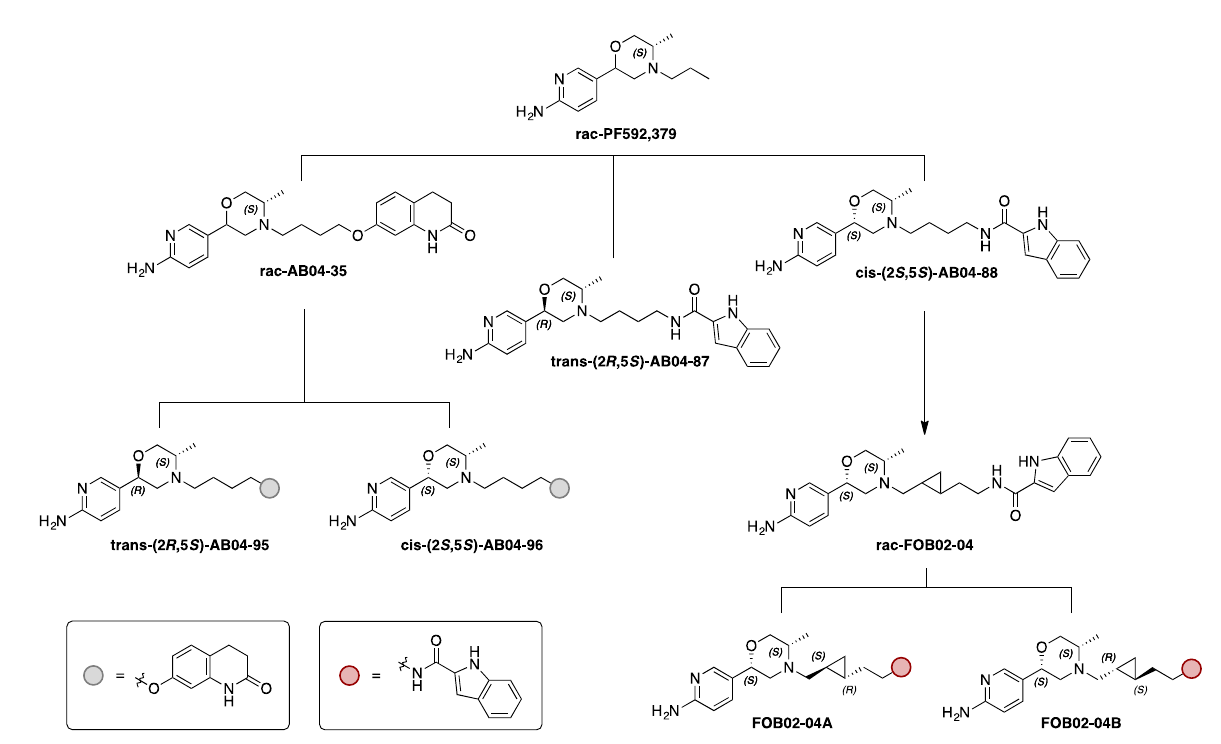
Figure 1. Drug design for D 3 R agonists. For the bitopic ligand design, the primary pharmacophore (PP) scaffold used was inspired by PF592,379. Several bitopic ligands based on the PF592,379 moiety were synthesized [43], among which the ligands shown were tested for functional characterization.